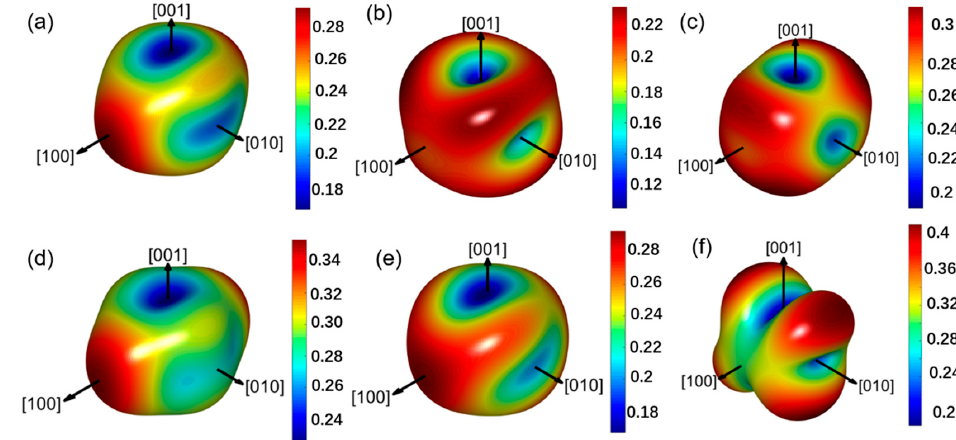
Figure 9. Poisson ratio 3D surface of Al 13 (Fe,M) 4 phases with different elements doping. ( a ) Al 13 Fe 4 , ( b ) Al 13 (Fe,Co) 4 , ( c ) Al 13 (Fe,Cr) 4 , ( d ) Al 13 (Fe,Cu) 4 , ( e ) Al 13 (Fe,Mn) 4 , ( f ) Al 13 (Fe,Ni) 4